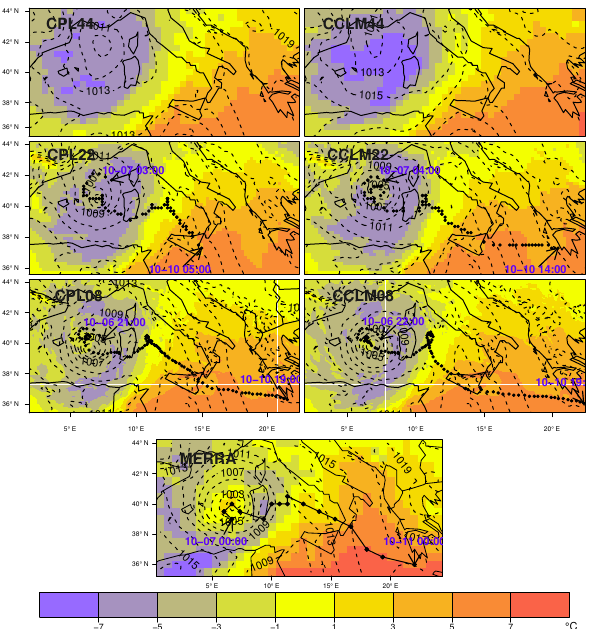
Figure 2. ME08; mean sea level pressure (hPa; dotted contours lines at 2hPa intervals) and temperature ( ◦ C: colored contours at 2 ◦ C in- tervals) at 700hPa in the coupled and atmosphere-only (0.44, 0.22, and 0 . 08 ◦ ) simulations and the MERRA reanalysis data on 7 Octo- ber 1996 at 18:00UTC. Black dots represent track of the medicane.